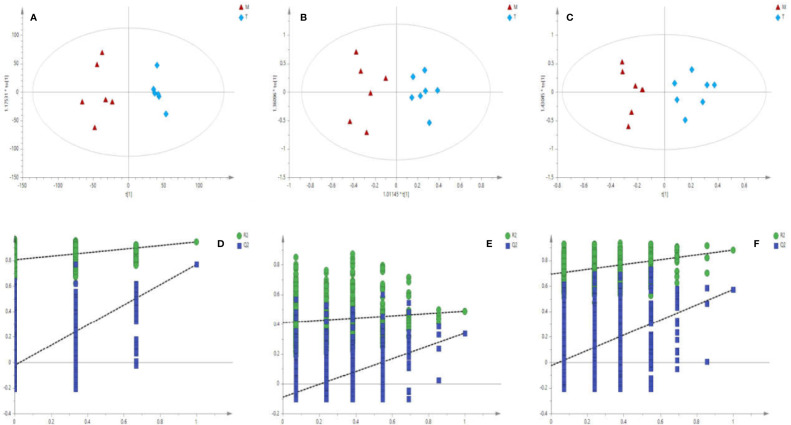
Score plots (A–C) of OPLS-DA Validation plots (D–F) obtained from 999 random permutation tests results between M (triangle) and T (rhombus) in uterine tissues; a, d: GC/MS; b, e: UFLC-IT-TOF/MS (ESI+); c, f: UFLC-IT-TOF/MS (ESI-).